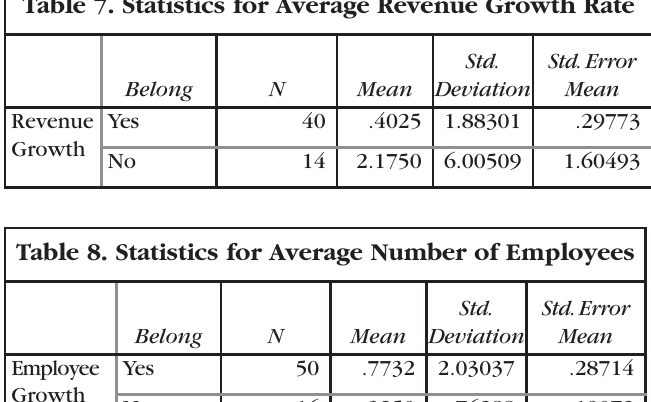
Table 7. Statistics for Average Revenue Growth Rate